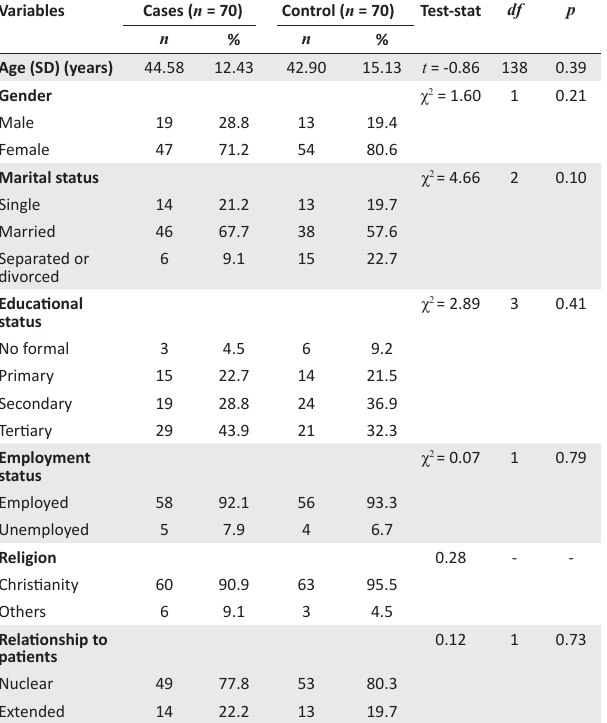
TABLE 1: Socio-demographic characteristics of the caregiver participants. Variables